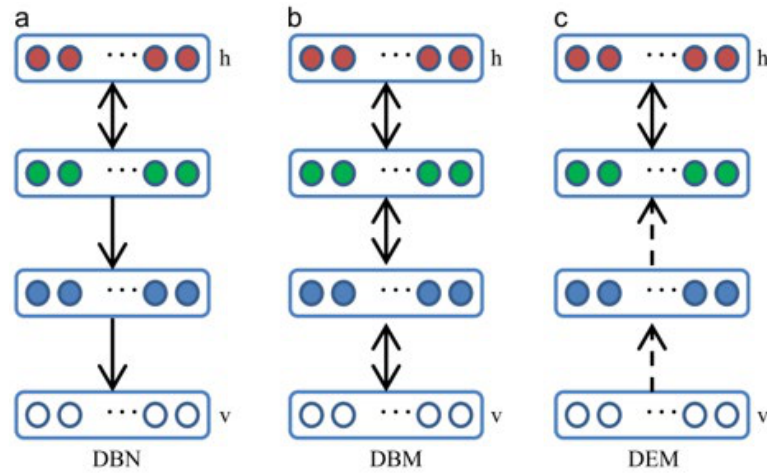
Figure 4. The illustration of RBM families, The RBM can be used as a learning module to create the following deep models: the DBN, DBM, and DEM. ( a ) The DBN has nondirectional connections in the upper two layers that form the RBM and directional connections to the lower layers. ( b ) The DBM has undirected connections between all layers of the network. ( c ) The DEM has a deterministic hidden unit in the lower layer and a stochastic hidden unit in the upper hidden layer.